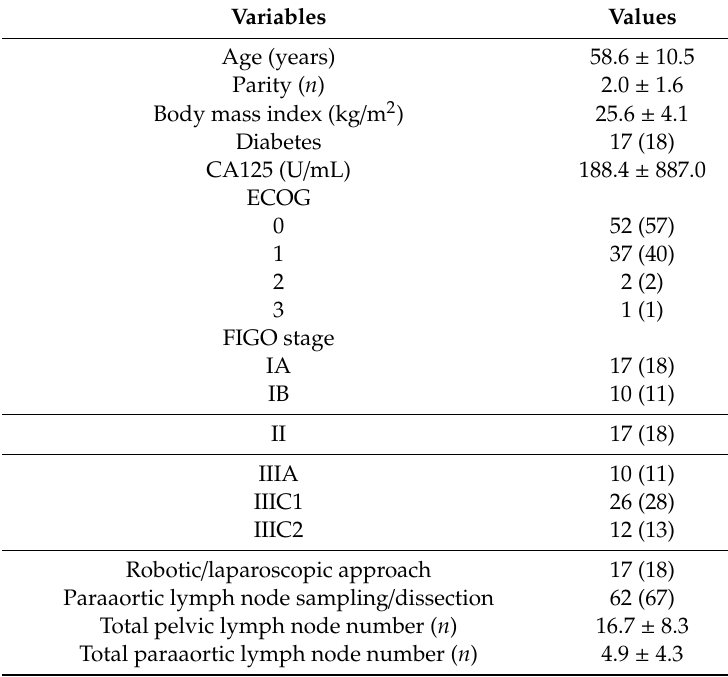
Figure 1. Patients with endometrial cancer. Table 1. Baseline data of high-risk endometrial cancer patients who underwent adjuvant therapy ( n = 92).